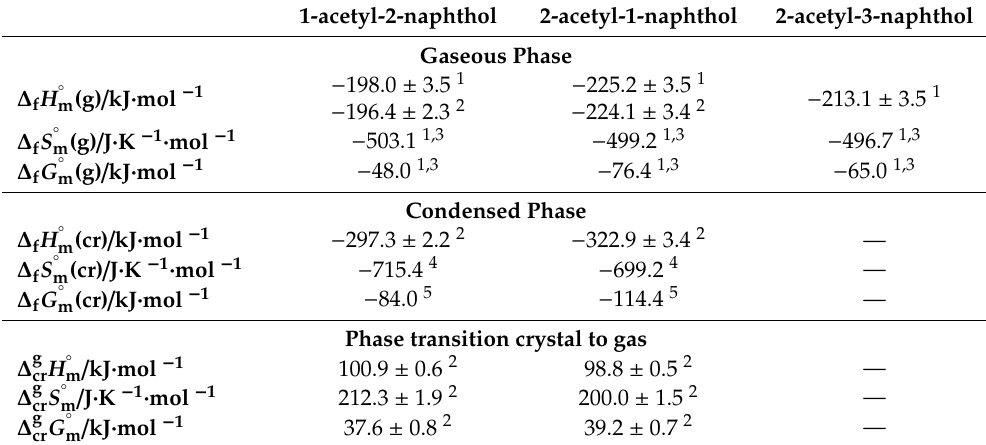
Table 4. Compilation of the thermodynamic results obtained for o -acetylnaphthol